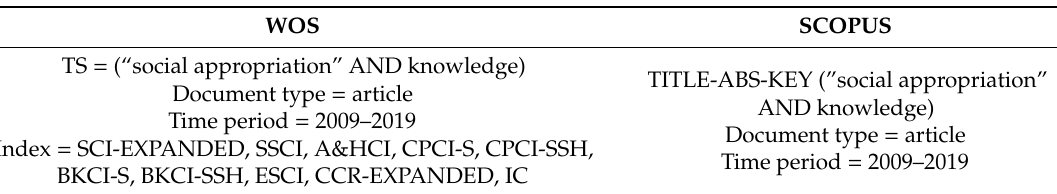
Table 1. Search descriptors.